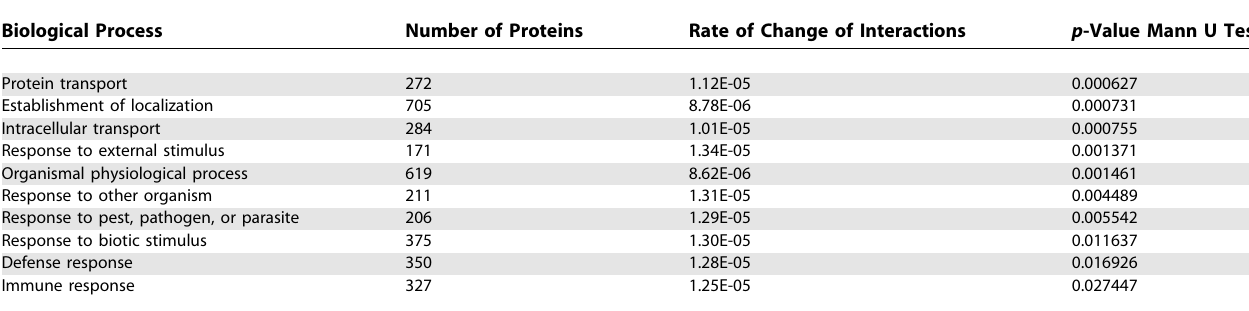
Table 4. Biological Processes with Above-Average Rate of Change of Interactions Biological